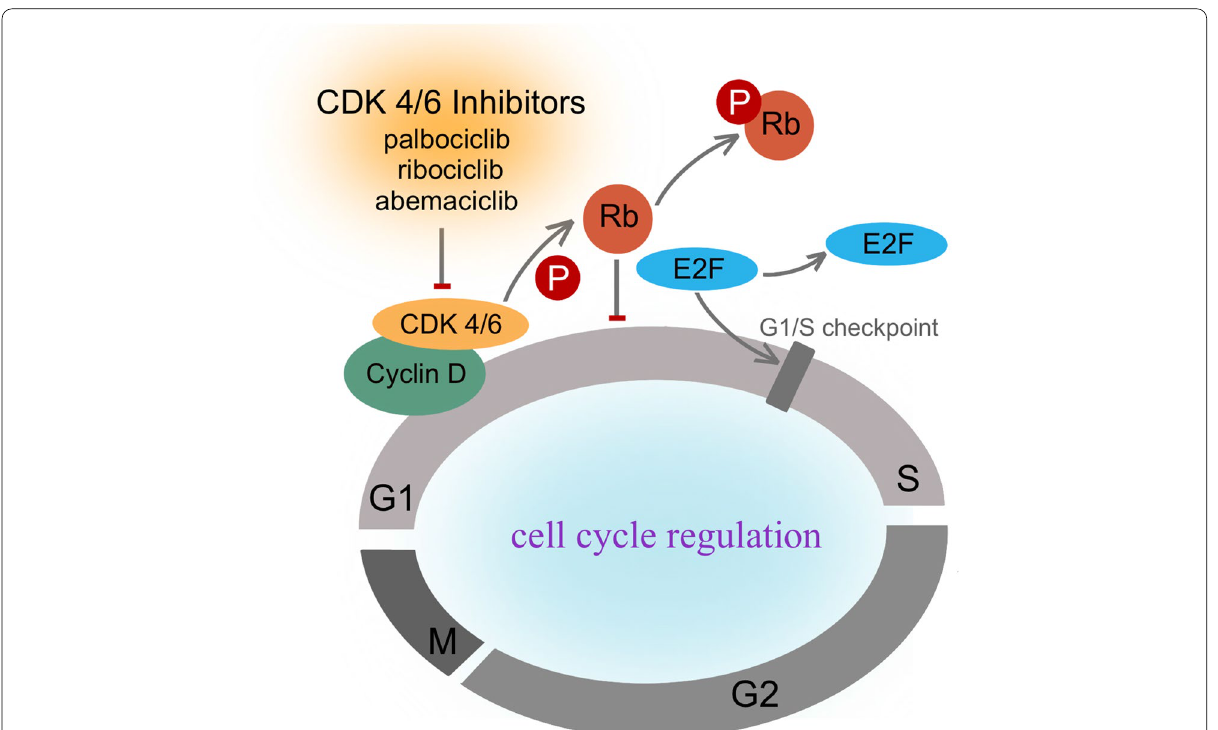
Fig. 2 Cyclin-Dependent Kinases 4/6 signaling pathways mediated cell cycle progression in TNBC. CDK 4/6—cyclin D complex gets into the nucleus, and then phosphorylates Rb. Phosphorylated Rb inhibits E2F, and initiates the cell into S phase and drives DNA replication. CDK4/6 inhibitors can inhibit Rb phosphorylation to prevent the proliferation of tumor